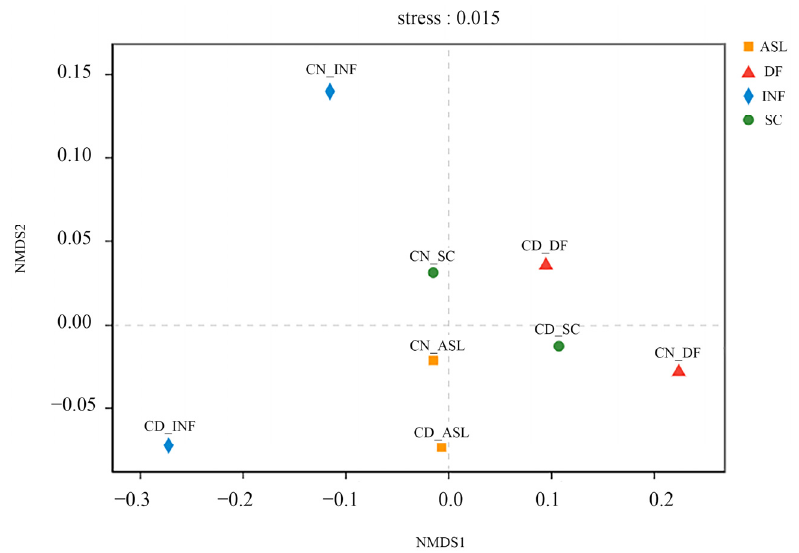
Figure 3. The similarity analysis of the total ARG relative abundance, using NMDS based on Bray– Curtis metrics. The distance between points represents the degree of difference between samples.